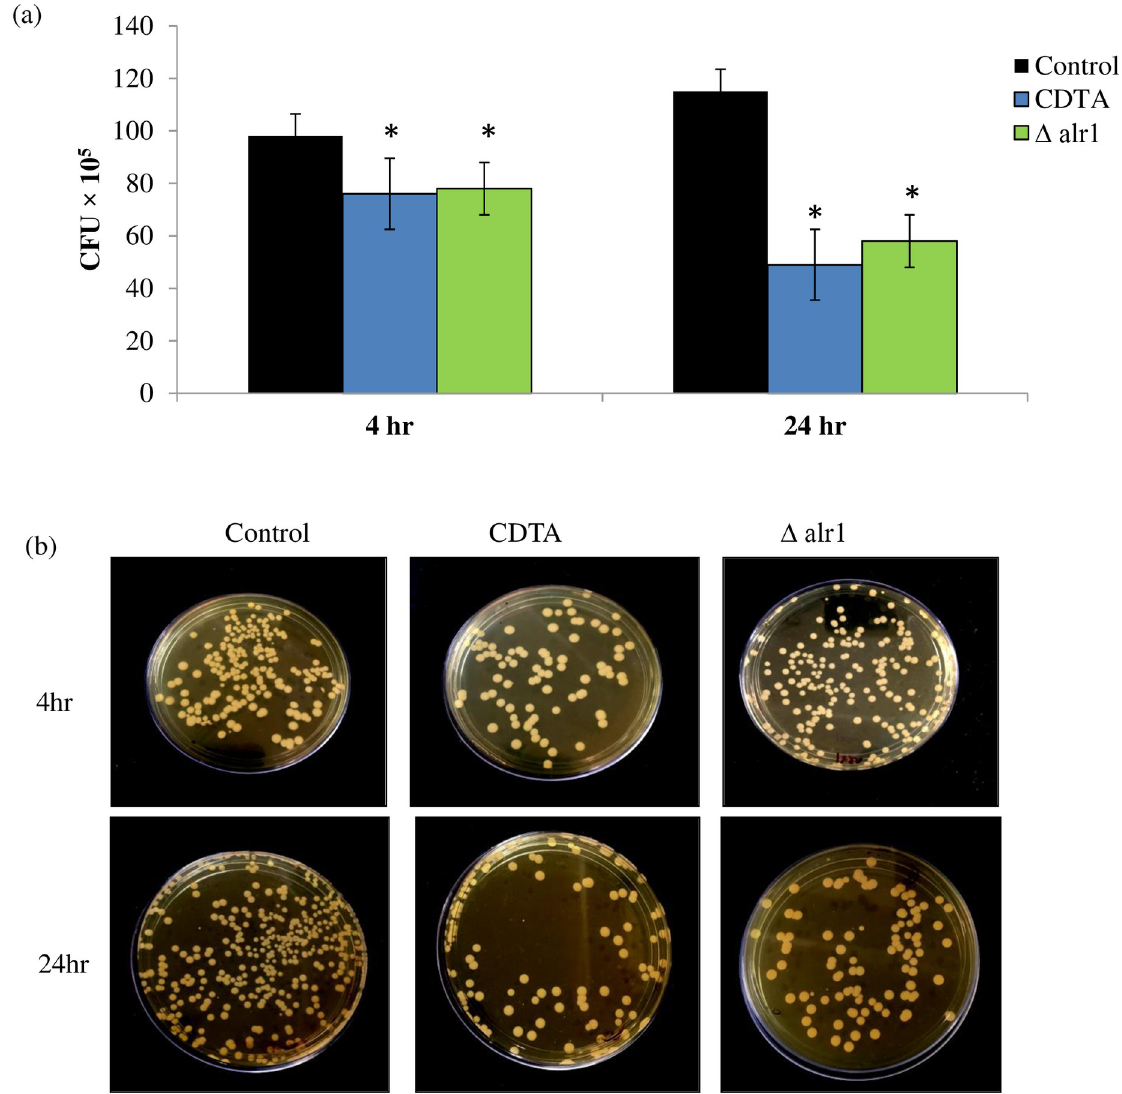
Fig 1. Macrophage killing under Mg deprivation. ( a ) Bar graph represents CFU log10 5 /ml on y-axis after 4- and 24-hours infection with control, CDTA treated and Δ alr1 C . albicans depicting the killing of C . albicans by macrophages. Data are expressed as mean ± SD of three independent sets of experiments. � depicts p value < 0.05. ( b ) CFU image of control, CDTA treated and Δ alr1 C . albicans after 4 and 24 hours